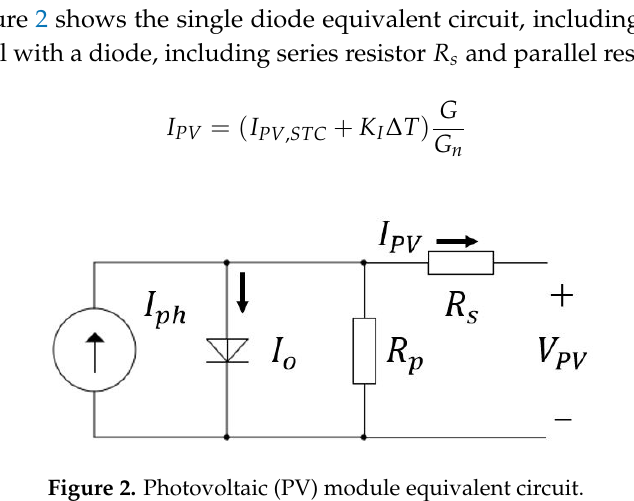
Figure 2. Photovoltaic (PV) module equivalent